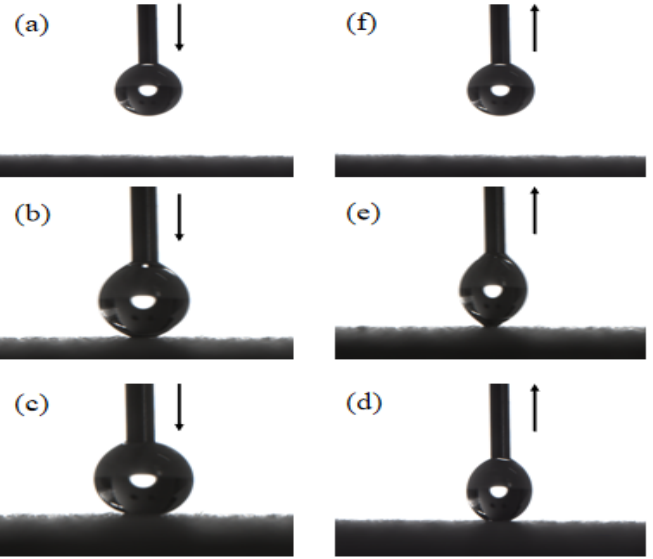
Figure 5. Continuous images of water droplets on a syringe suspended on the HTW surface: ( a – f ). The arrows indicate the direction of motion of the syringe.